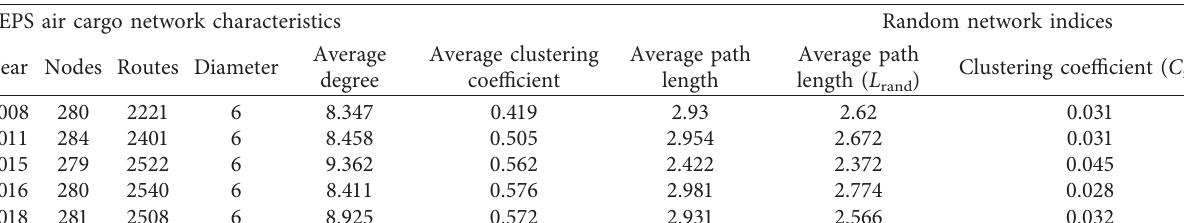
Figure 1: FEPS air cargo network topology in 2008, 2014, and 2018. Table 2: FEPS network complex network characteristics from 2008 to